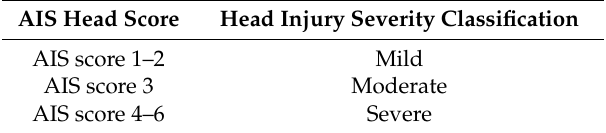
Table 1. Abbreviated Injury Score (AIS) head score and head injury severity classification.